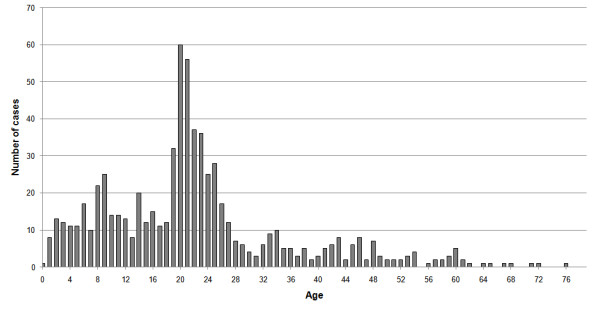
The number of swine flu cases at each age.